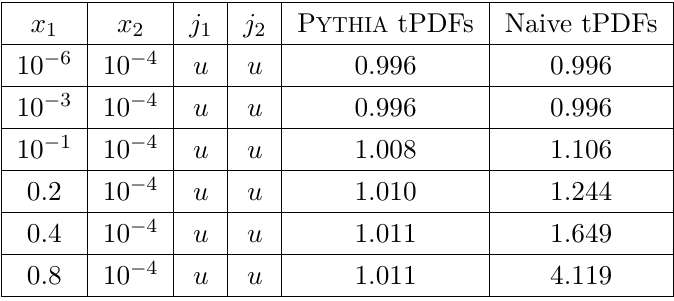
Table 8 . Test of the momentum sum rule for the tPDFs. In the ideal situation when the momentum sum rule is perfectly satisfied the number in each cell should be equal to